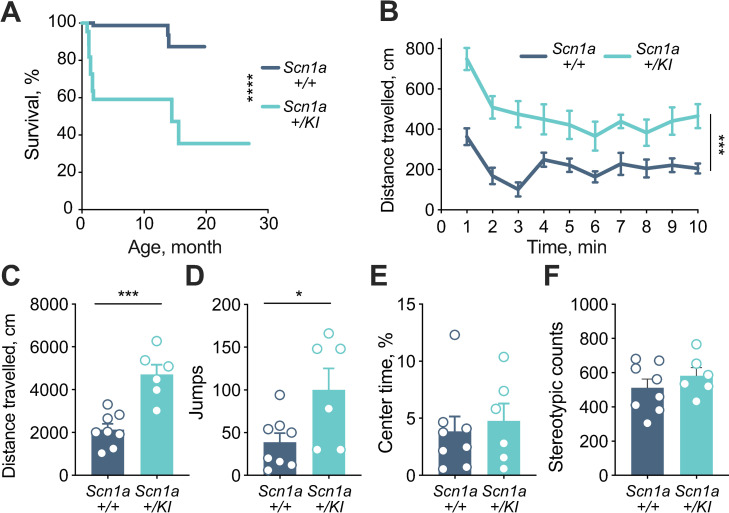
Scn1a+/KI mice exhibit premature mortality and a hyperactivity phenotype.(A) Kaplan-Meier analysis showed severe premature mortality in Scn1a+/KI mice (n = 22–93, Log-rank (Mantel-Cox) test, p < 0.0001). This analysis started at weaning, when genotyping was performed, and so does not include additional mortality observed in litters prior to weaning. (B) Distance travelled in the open field as a function of time is increased in Scn1a+/KI mice (n = 6–8, 13.81 ± 0.47 months, two-way RM-ANOVA, interaction p = 0.0150, main effects of time p < 0.0001 and genotype p = 0.0003). (C) Total distance travelled during 10 minutes in the open field is higher in Scn1a+/KI mice (n = 6–8, 13.81 ± 0.47 months, Student’s unpaired t-test, p = 0.0003). (D) Vertical jumps in the open field apparatus are higher in Scn1a+/KI mice (n = 6–8, 13.81 ± 0.47 months, Student’s unpaired t-test, p = 0.0305). (F) No difference between genotypes were found in stereotypic counts in the open field (n = 6–8, 13.81 ± 0.47 months, Student’s t-test, p = 0.3444). (E) No difference between genotypes in percent time spent in the center of the open field (n = 6–8, 13.81 ± 0.47 months, Student’s unpaired t-test, p = 0.6598). All data are expressed as mean +/–SEM; *p < 0.05, ***p < 0.001 and ****p < 0.0001.